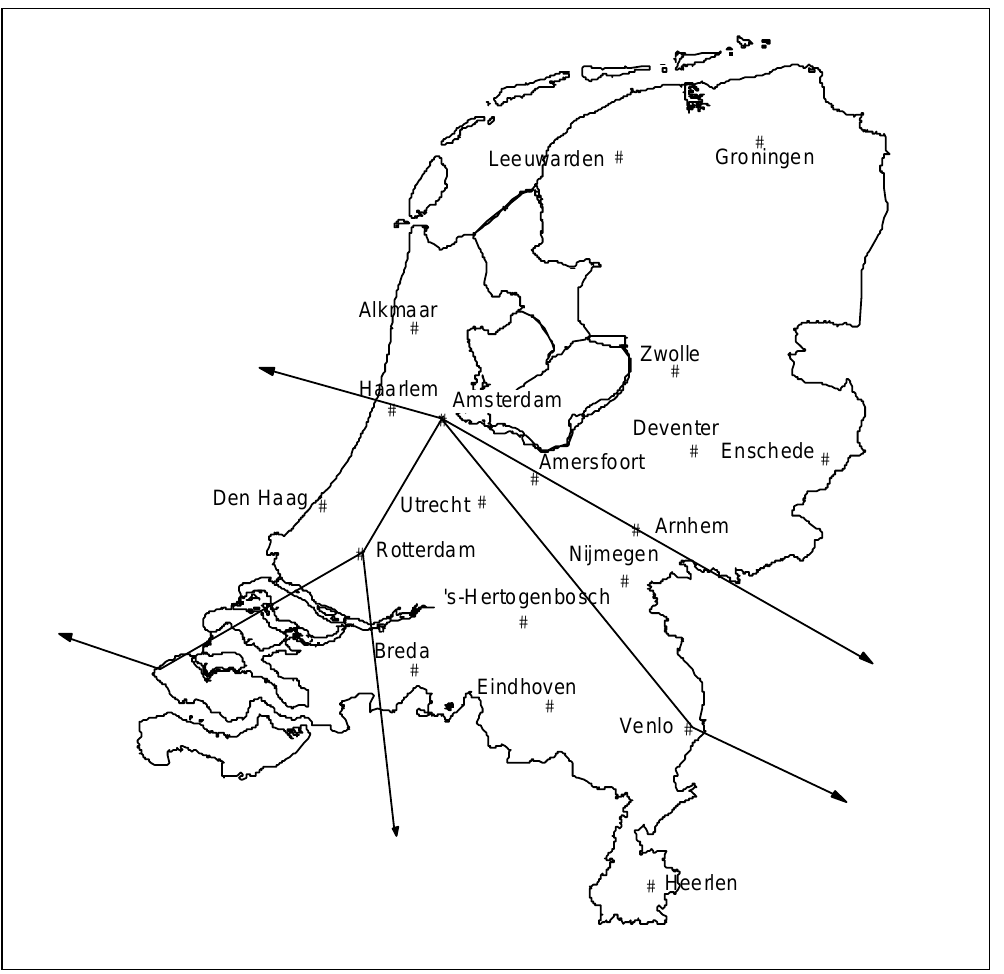
Figure 6. Footprint across the Netherlands DDV (1999: 27-34) has mapped out the current telecommunications infrastructure of the Netherlands. The primary infrastructure of most operators (the ‘backbones’ or transport nets) all have more or less the same footprint across the Netherlands (figure 7). Following a phased development starting in Randstad Holland, the mobile nets have also numbers of transmitter